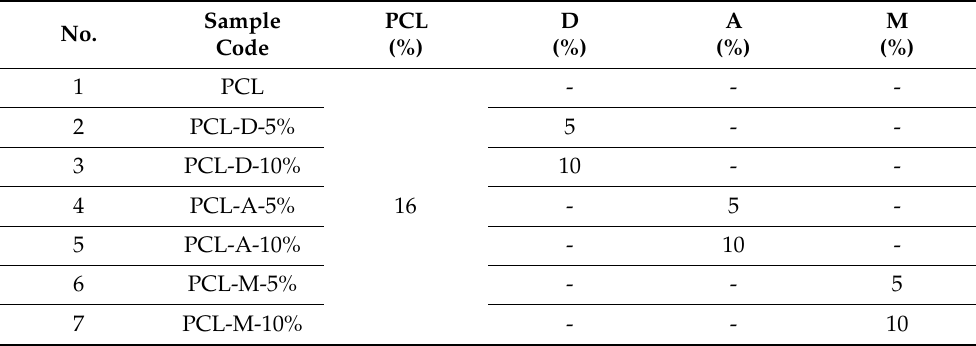
Table 1. Composition of the electrospinning